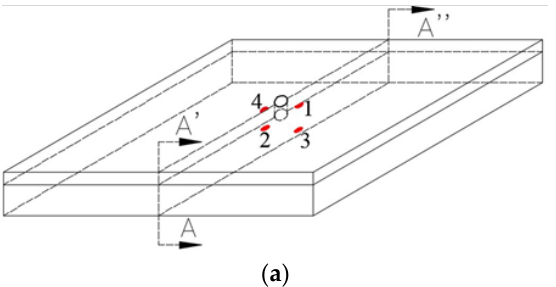
Figure 4. Schematic view of thermocouples. ( a ) A-A’-A” cross-section in the middle of the specimen; ( b ) arrangement and designation of thermocouples.